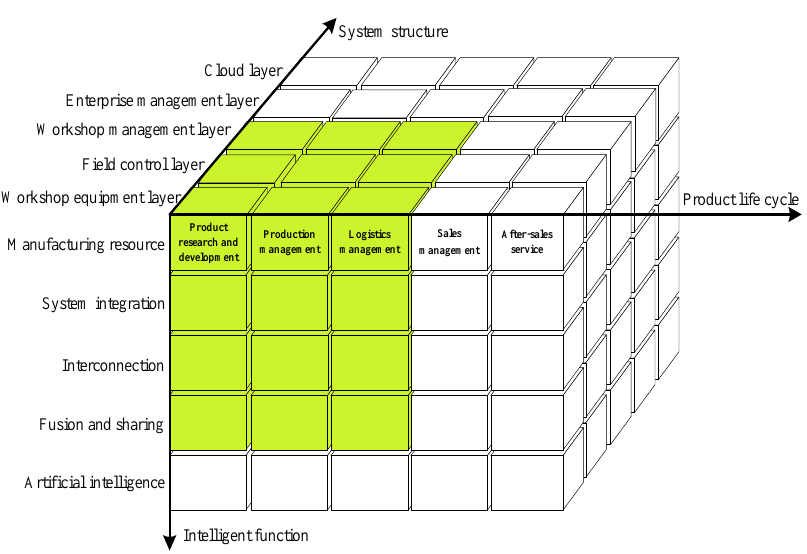
Figure 1. Intelligent manufacturing system architecture and scope of intelligent workshop coverage.